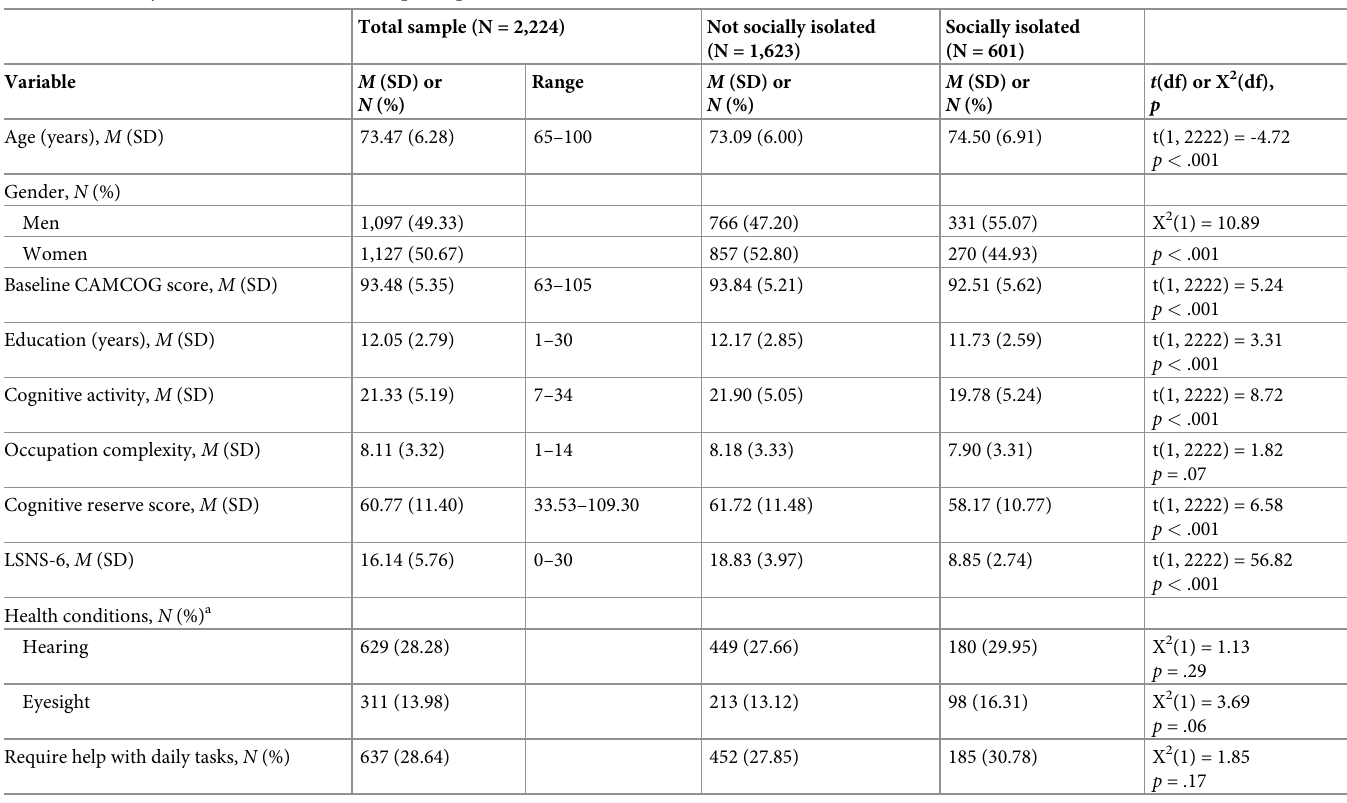
Table 1. Summary of baseline characteristics of participants in CFAS-Wales.